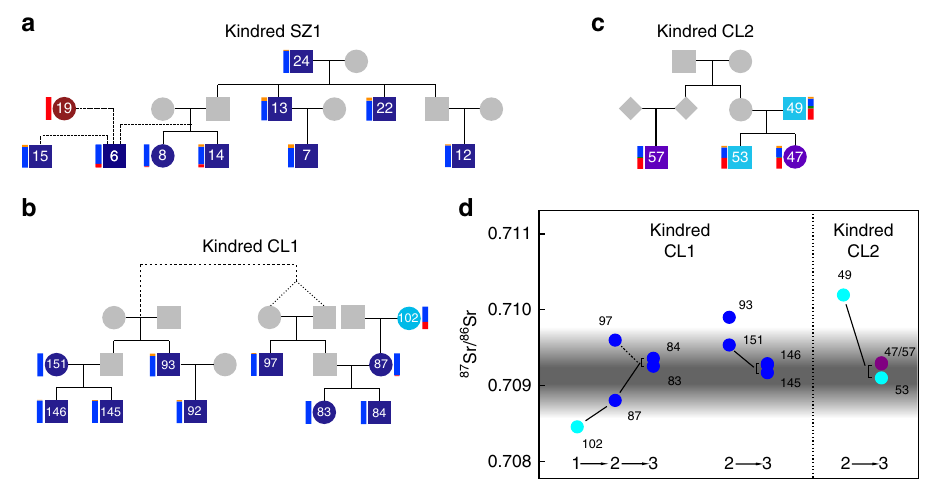
Fig. 4 Major kindreds in Szólád and Collegno. Kindreds SZ1 ( a ), CL1 ( b ), and CL2 ( c ), with colors corresponding to criteria and labeling in Fig. 2. ADMIXTURE coef fi cients (vertical bars on side of each individual) estimated using 1000 Genomes 21 European populations only. Dashed lines indicate relationships of unknown degree (including past inbreeding in the parents of CL97). d Displays strontium isotope ratios for Kindreds CL1 and CL2 where available. Estimate of local range at Collegno is shown using black shading, as detailed in Fig. 4. Numbers indicate generations (1 being the oldest, 3 being the